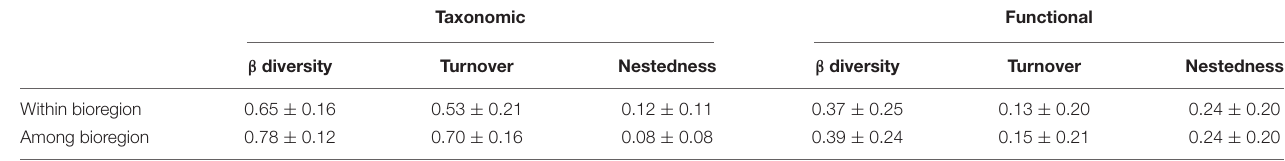
TABLE 4 | Taxonomic and functional β diversity and its two components; mean ± standard